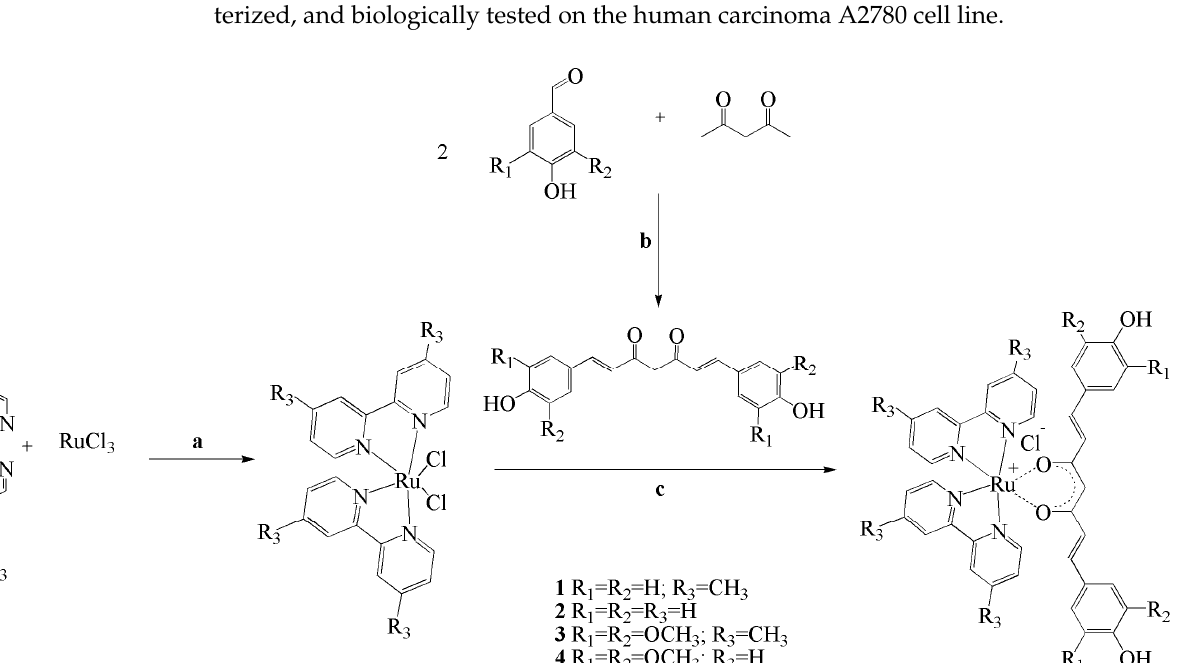
. Figure 2. Structures of prepared ruthenium complexes 1 − 4. 2.2. Biological Attempts-Cytotoxicity